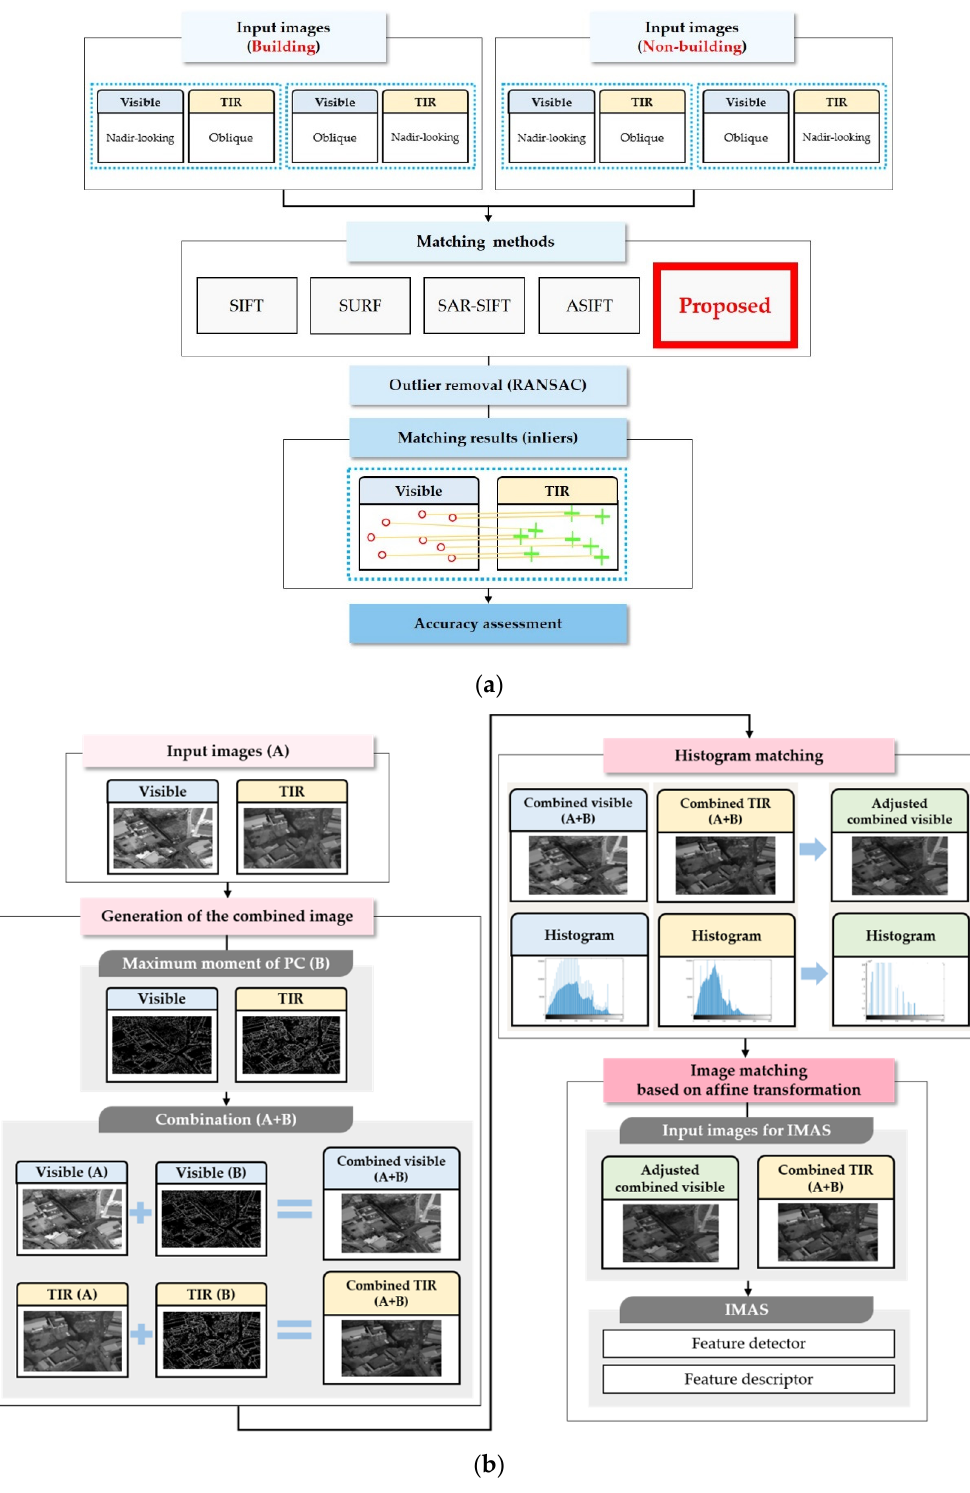
Figure 1. Research flow: ( a ) macroscopic frame of method; ( b ) detailed flow chart of the proposed (red square box in ( a )) method in this study.